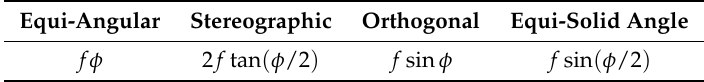
Table 1. Definition of h ( φ ) = ˆ r for different fish-eye